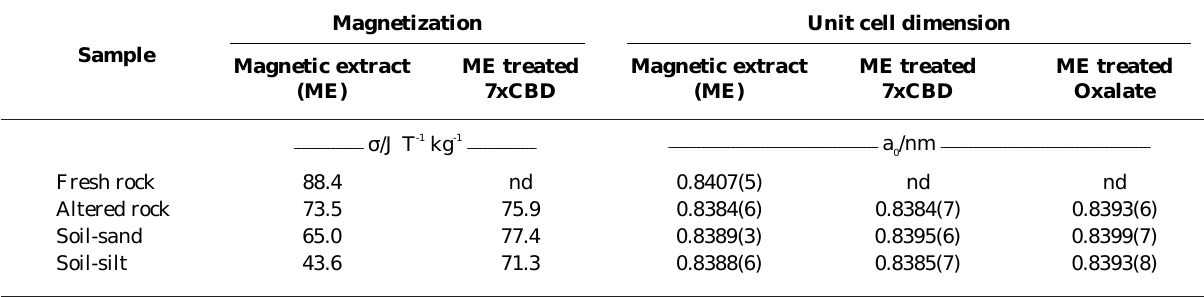
Table 2. Magnetization and unit cell dimension of magnetite of whole magnetic extract and 7xCBD and